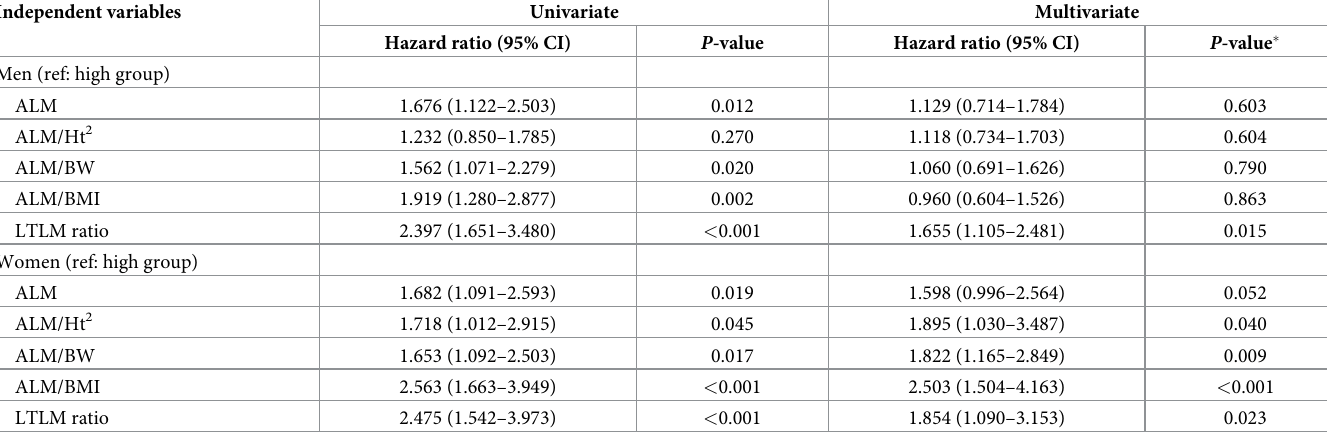
Table 4. Univariate and multivariate hazard ratio for all-cause mortality according to the low group for each lean mass index. Independent